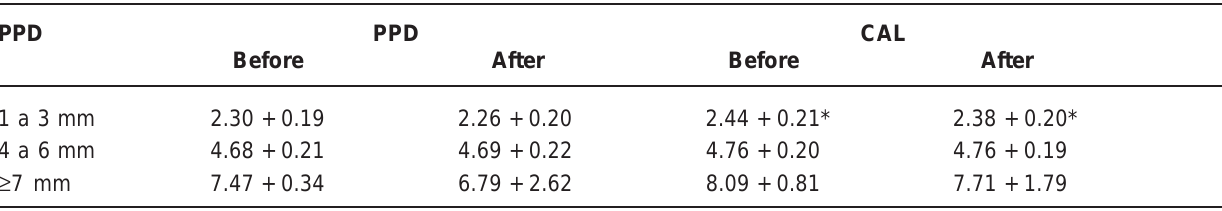
* indicates statistically significant difference (P<0.05) detected with the paired t